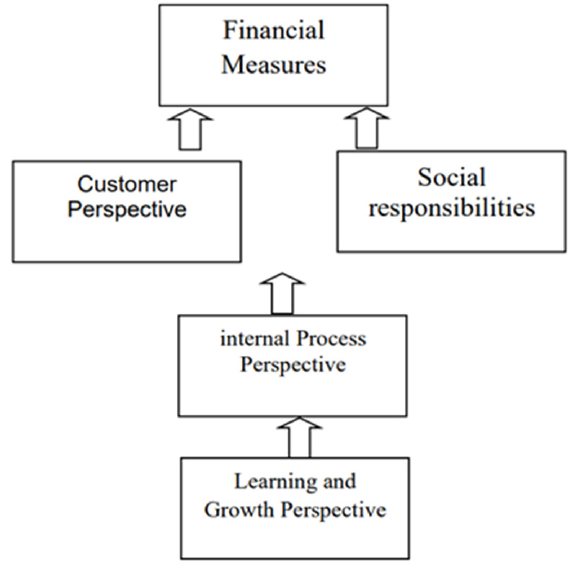
Figure 3. Cause and effect relationship in the balanced scorecard.